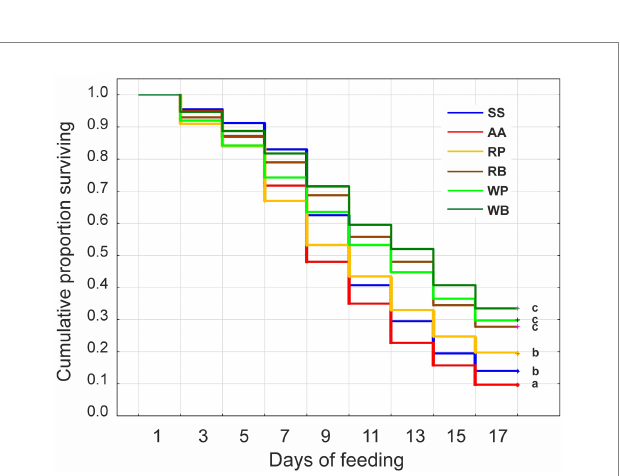
FIGURE 2 Kaplan–Meier survival curves for worker bees fed different diets for 17 days. The administration of the diets was started 2 days after the hatching of the bees. SS, sucrose solution (control group); AA, sucrose solution + amino acids; RP, sucrose solution + rapeseed pollen; RB, sucrose solution + rapeseed beebread; WP, sucrose solution + willow pollen; and WB, sucrose solution + willow beebread. Different letters indicate significant differences between the values ( p <